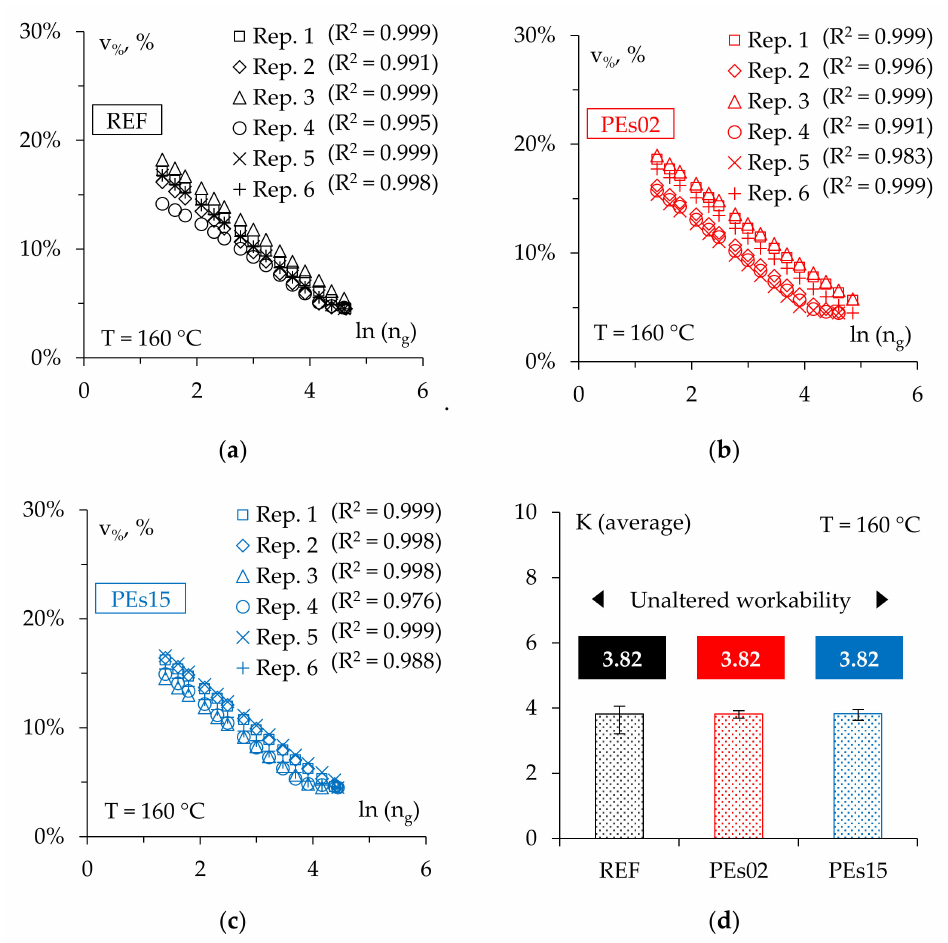
Figure 5. The compaction curves (( a ) REF; ( b ) PEs02; ( c ) PEs15) and the workability ( d ) of the mixes.